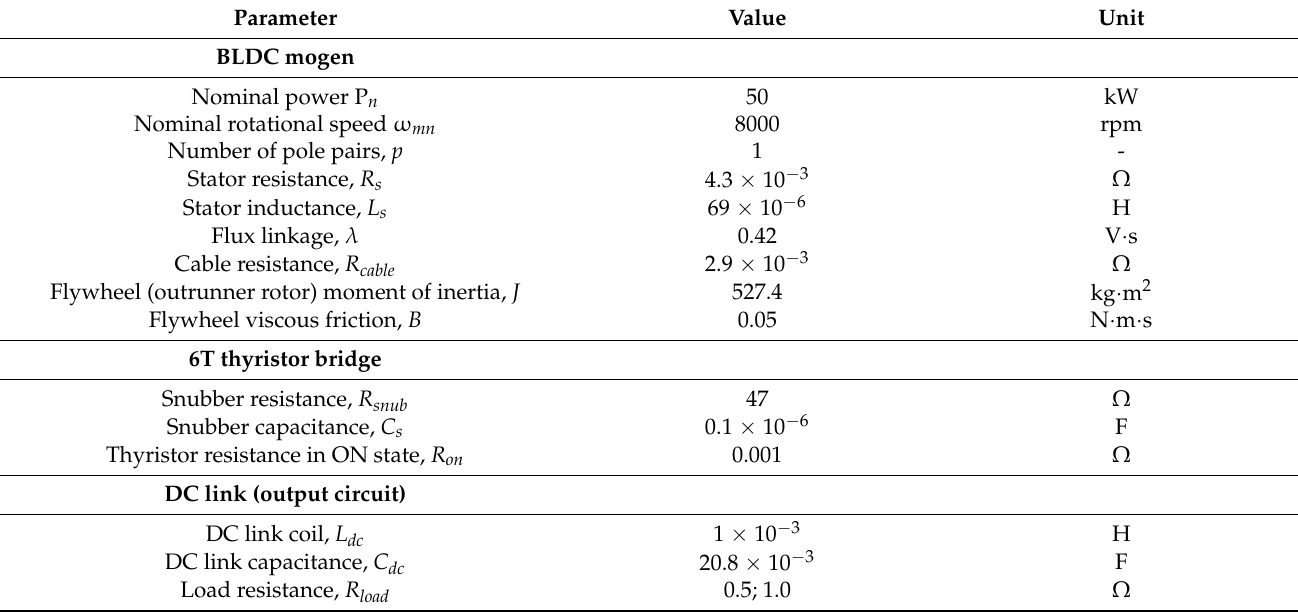
Table 2. Parameters of the energy recovery subsystem simulation